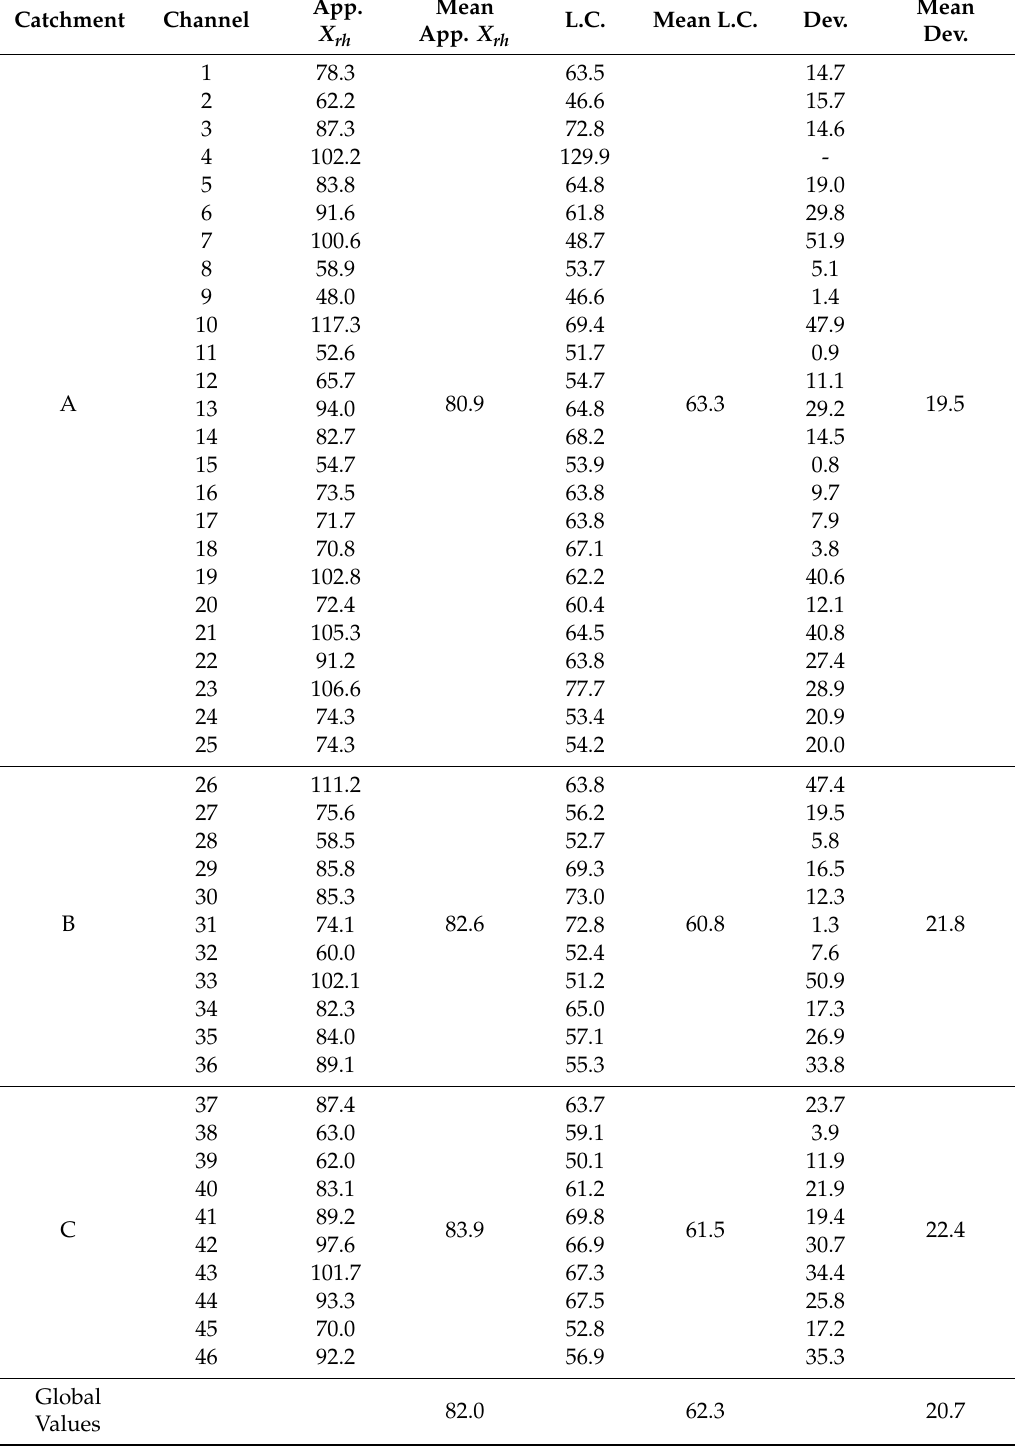
Table 2. Measured values of the apparent X rh (ridge to head of channel distance) and LiDAR convex slope length, in meters. The deviation between those values is also shown for each channel, in meters. App. X rh = Apparent X rh ; L.C. = LiDAR convex slope length; Dev. = Deviation between the X rh and L.C.